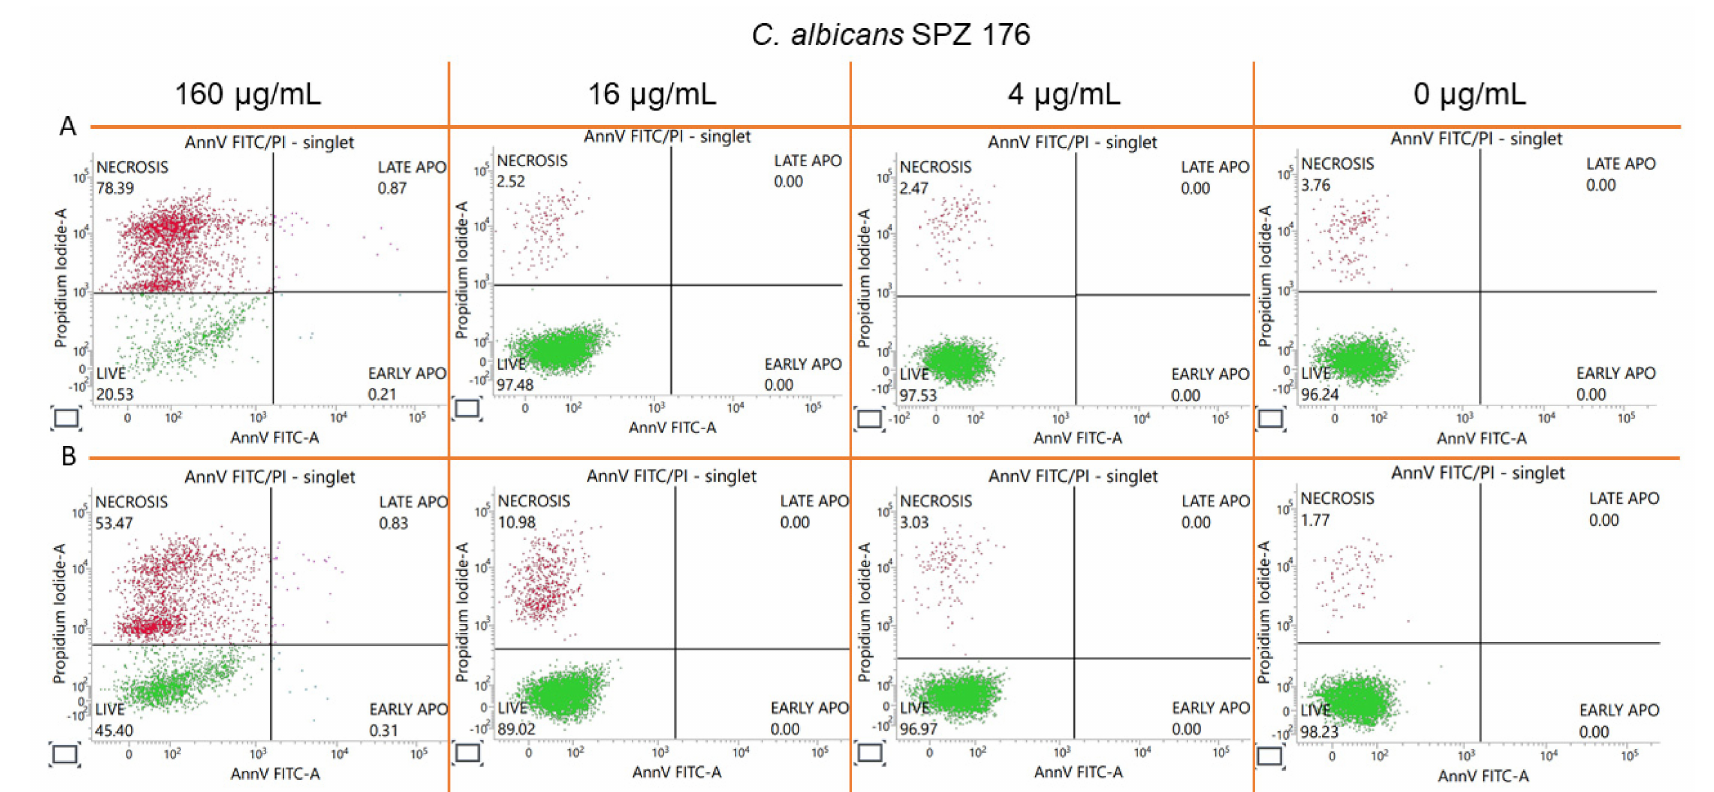
Figure 3. Flow cytometric analysis of the cell death type of C. albicans SPZ176 treated with 5h . Legend: ( A ) cells; ( B ) protoplasts; EARLY APO means early apoptosis; LATE APO means late apoptosis. Data represent mean ± SD, n =